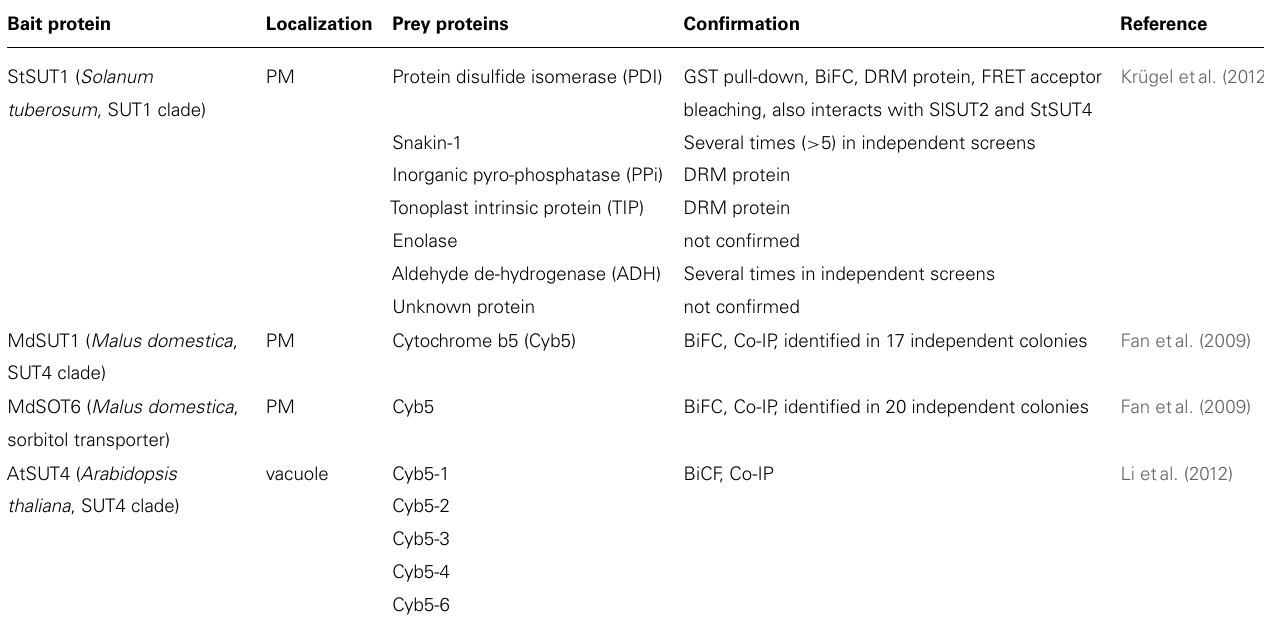
Table 1 | Protein–protein interaction partners of plant sugar transporters identified by the yeast two hybrid split ubiquitin system. Bait